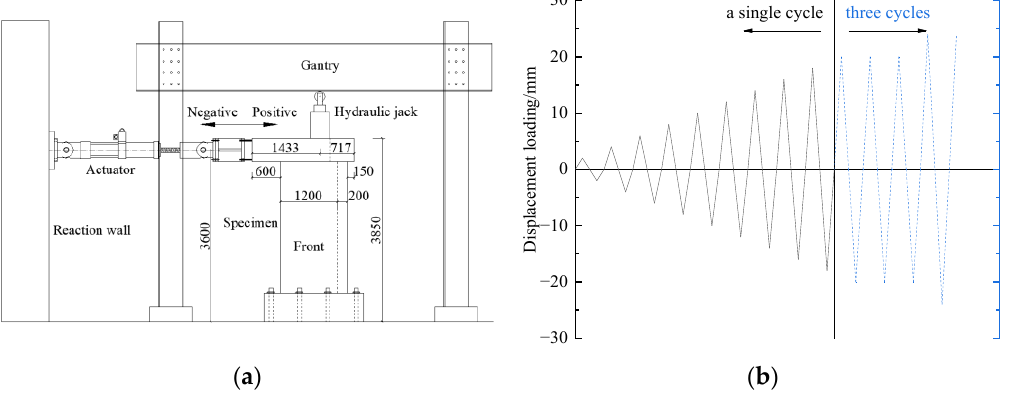
Figure 4. Setup of the test. ( a ) Loading device; ( b ) Loading system.